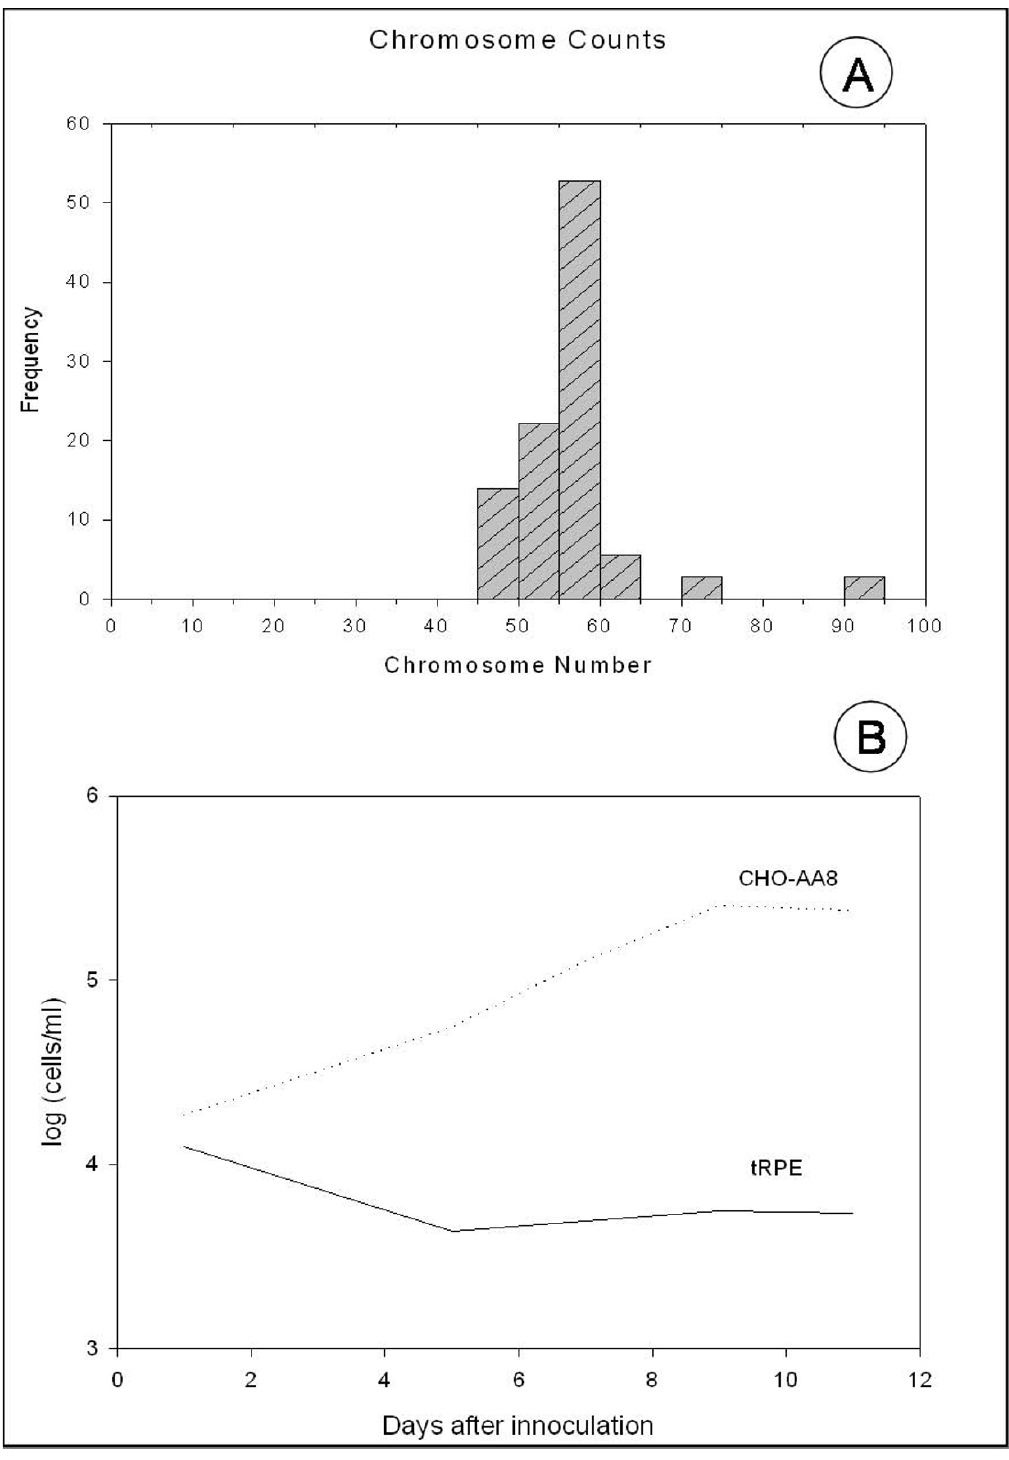
Figure 6 Graphical analysis of transformation experiments using tRPE cultures . A) Frequency of chromosome counts of pas- sage 102 tRPE cells (n = 63); B) Growth curves of passage 102 tRPE cells compared to CHO cells grown in suspension cul-